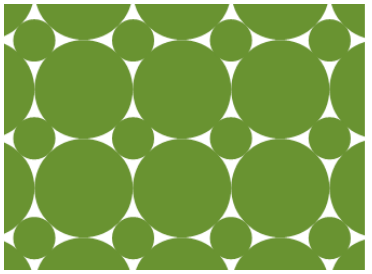
Figure 1. Tangent arrangement of rock particles without extrusion.